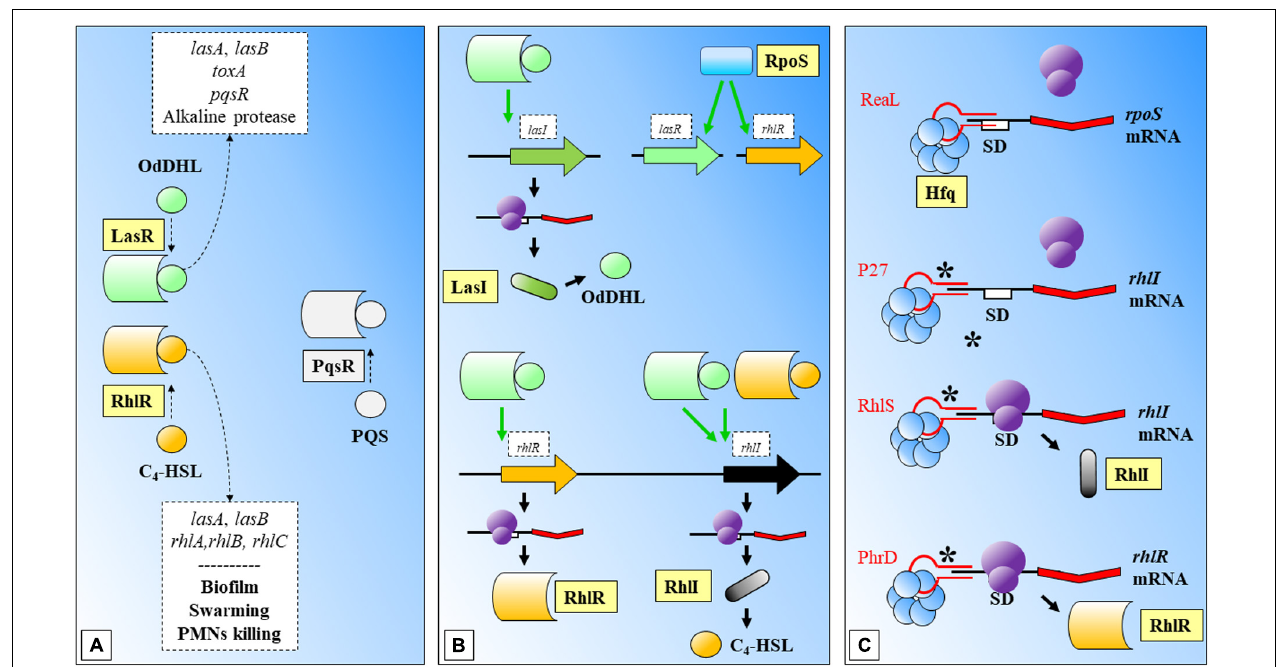
FIGURE 3 | Biofilm formation and Quorum Sensing in Pseudomonas aeruginosa . (A) LasR and RhlR are two key regulatory molecules that need OdDHL and C 4 -HSL participation. LasR-OdDHL regulate the genes included in the upper box. RhlR-(C 4 -HSL) regulate genes or affect processes indicated in the lower box. PqrS is another important regulator, it has been shaded as it does not participate in the shown processes. (B) LasR and RhlR expression is dependent on RpoS. LasR-OdDHL regulates positively: the expression of lasI , and ultimately the synthesis of OdDHL; the expression of rhlR ; and rhlI . RhlR-(C 4 -HSL) regulates positively the expression of rhlI . (C) Mechanisms of action of several sRNAs involved in regulation of the synthesis of regulatory proteins within these signaling systems: ReaL affects negatively the expression of rpoS ; P27 is another negative regulator, in this case of rhlI ; RhlS regulates positively rhlI ; PhrD is a positive regulator of rhlR . C 4 -HSL: N-butanoyl-homoserine lactone; OdDHL: N-(3-oxododecanoyl)-L-homoserine lactone; PQS: Pseudomonas quinolone signal; SD: Shine-Dalgarno. Black thick arrows indicate flow of a biological process, e.g., protein translation. Green thick arrows indicate activation. Dashed-line text boxes: indicate downstream effects of the two signaling systems, phenotypes are indicated in bold (e.g., swarming). ∗ : indicates that this mechanism of sRNA regulation has been proposed. References: Schuster et al., 2004; Nadal Jimenez et al., 2012; Brouwer et al., 2014; Pita et al., 2018; Thi Bach Nguyen et al., 2018; Chen et al., 2019; Malgaonkar and Nair,